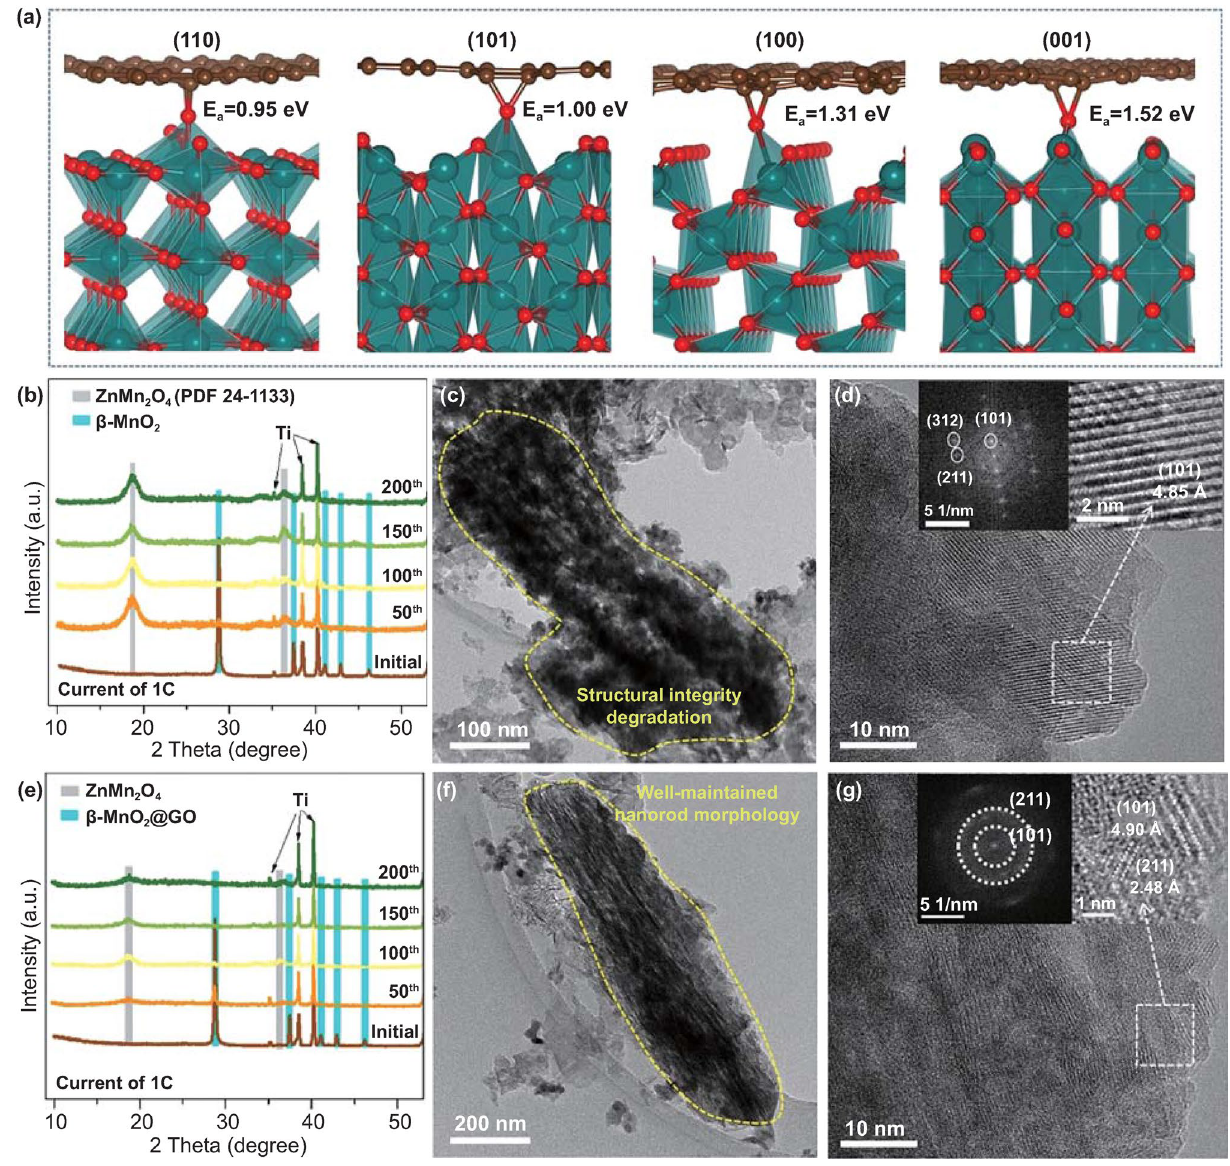
Fig. 5 a DFT calculated binding configuration and adsorption energies ( E a ) of GO on β-MnO 2 (110), (101), (100), and (001) terraces with a surface V O . b XRD patterns of β-MnO 2 electrodes of pristine and at charged state after 50, 100, 150, and 200 cycles at current of 1C. c , d TEM morphologies of active material in β-MnO 2 electrode after 200 cycles at current of 1C, showing a degradation on structural integrity, and the corresponding HRTEM images (inset, diffraction pattern of ZnMn 2 O 4 spinel). e XRD patterns of β-MnO 2 @GO electrodes of pristine and at charged state after 50, 100, 150, and 200 cycles at current of 1C. f , g TEM morphologies of active material in β- MnO 2 @GO electrode after 200 cycles at current of 1C, showing a well-maintained nanorod morphology, and the corresponding HRTEM images (inset, diffraction rings show- ing (211) and (101) planes of nanocrystalline Zn x Mn 2 O 4